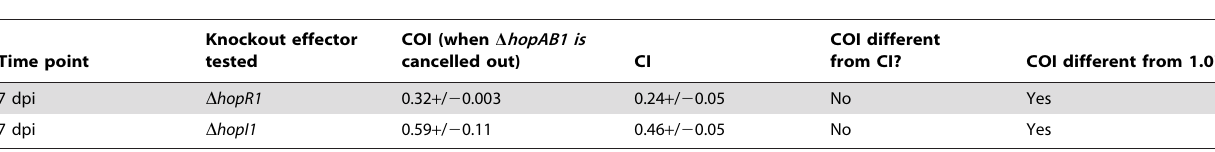
Table 3. Epistatic analysis of HopAB1 function on the contribution to virulence of HopR1 and HopI1.